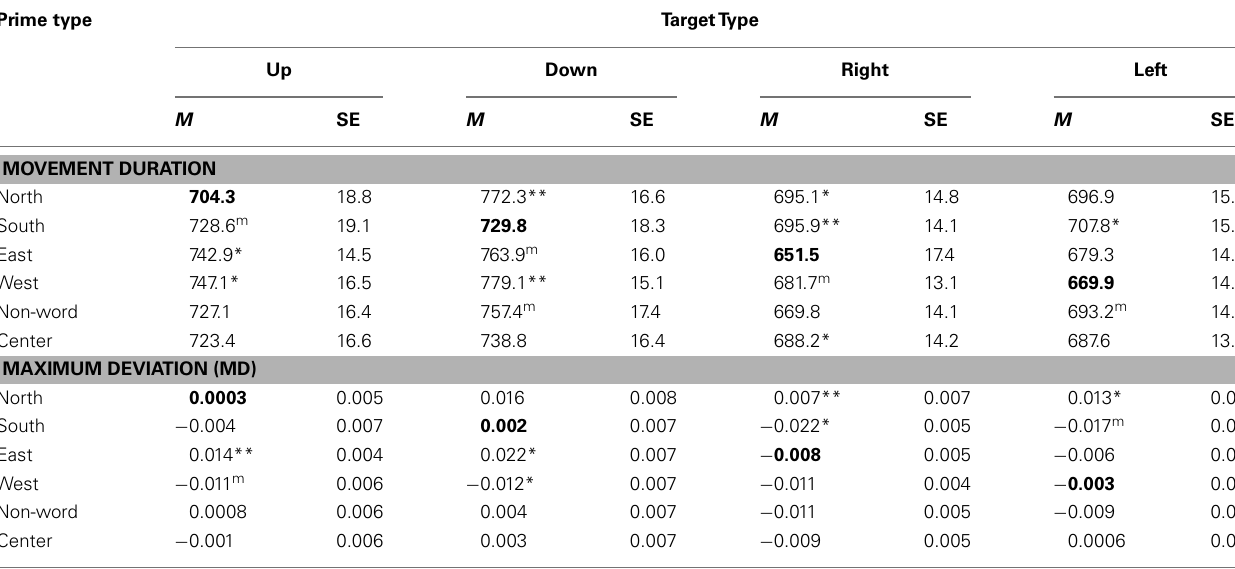
Table 1 | Experiment 1 mean and standard error movement duration and maximum deviation (MD) data for each of the six prime types and four target types.